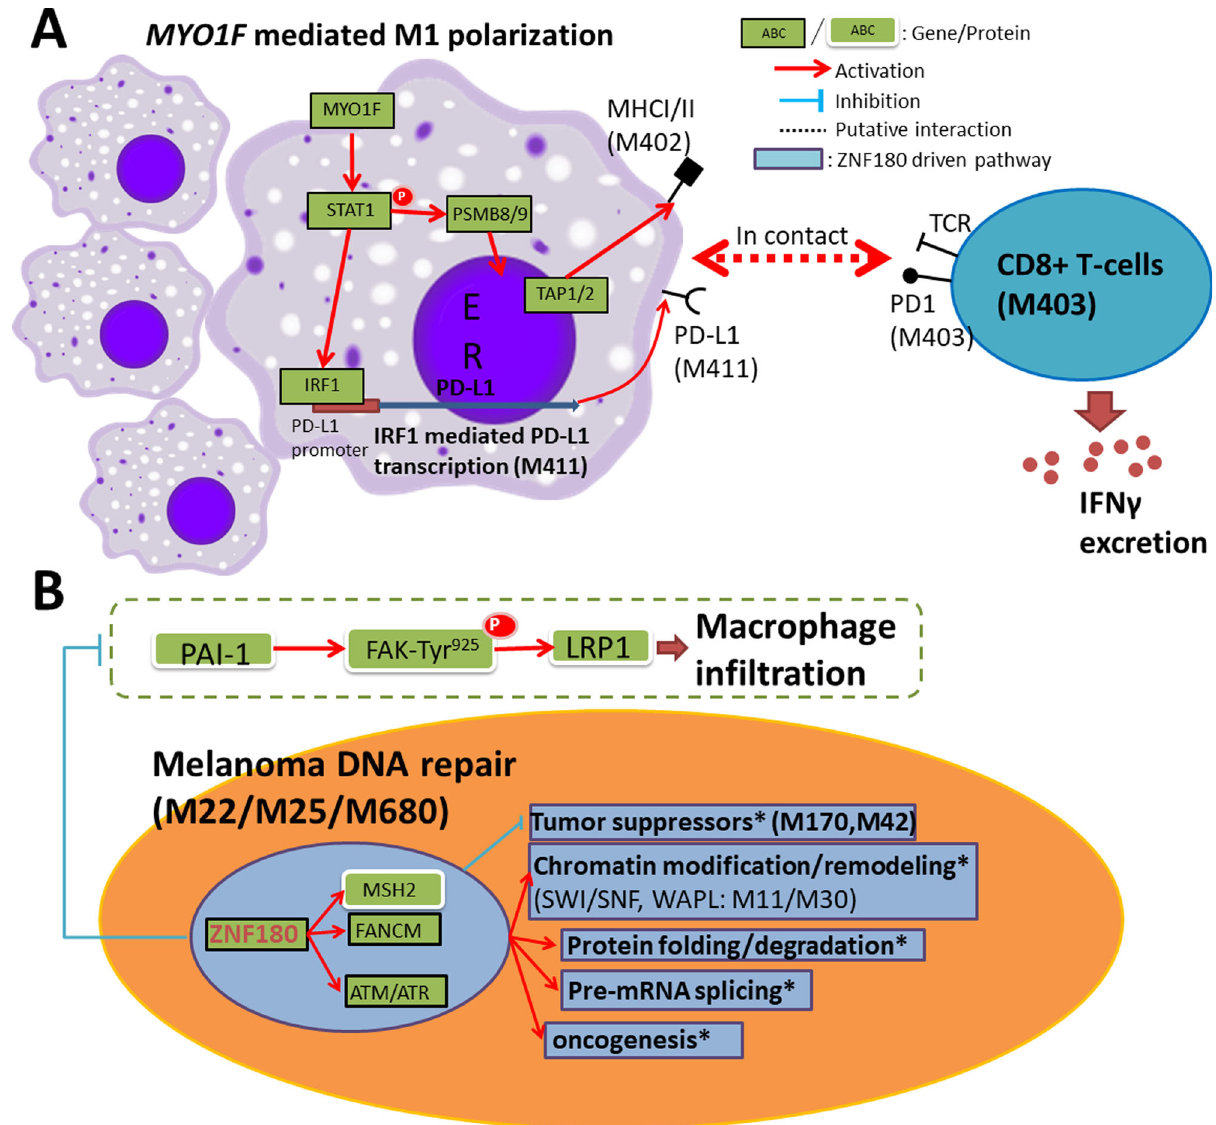
Fig. 5 Key signaling pathways in primary melanoma captured by the bulk pSKCM and single-cell gene networks. A MYO1F mediated M1-polarization of macrophages is associated with a good prognosis. Contact with CD8 + T cells leads to increased IFN γ excretion in the tumor microenvironment. B ZNF180 overexpression drives DNA repair and downstream melanoma pathways and suppresses macrophage in fi ltration via decreased PAI-1 protein